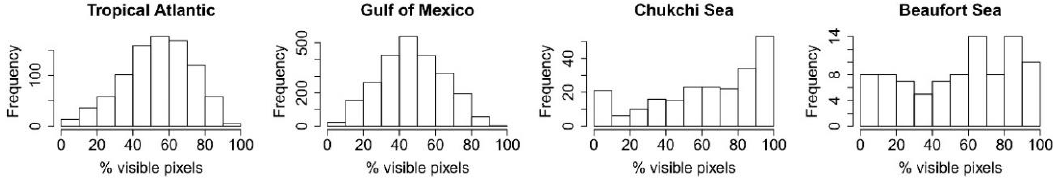
Figure 2. Percent of pixels that were visible during the study seasons (see Table 1) in 8-day composites (Tropical Atlantic, Beaufort Sea, Chukchi Sea) and 3-day composites (Gulf of Mexico) of binned MODIS-Aqua Chl a data.